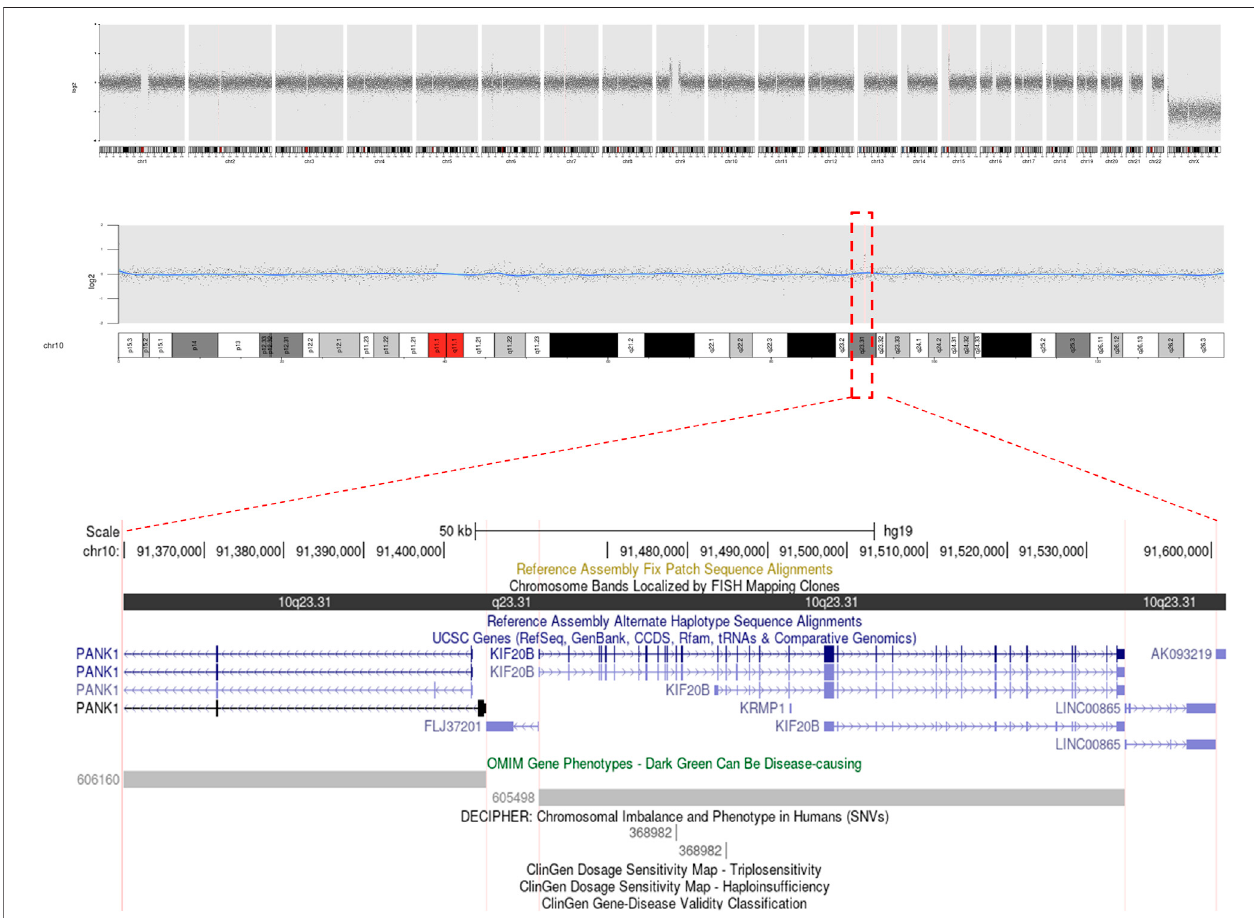
FIGURE3| Copynumbervariation(CNV)analysiswasperformonthecase.Amicroduplication10q23.31(chr10:91371499-91596485)hadbeenshown,affecting genes of FLJ37201, KIF20B, LINC00865, and PANK1.